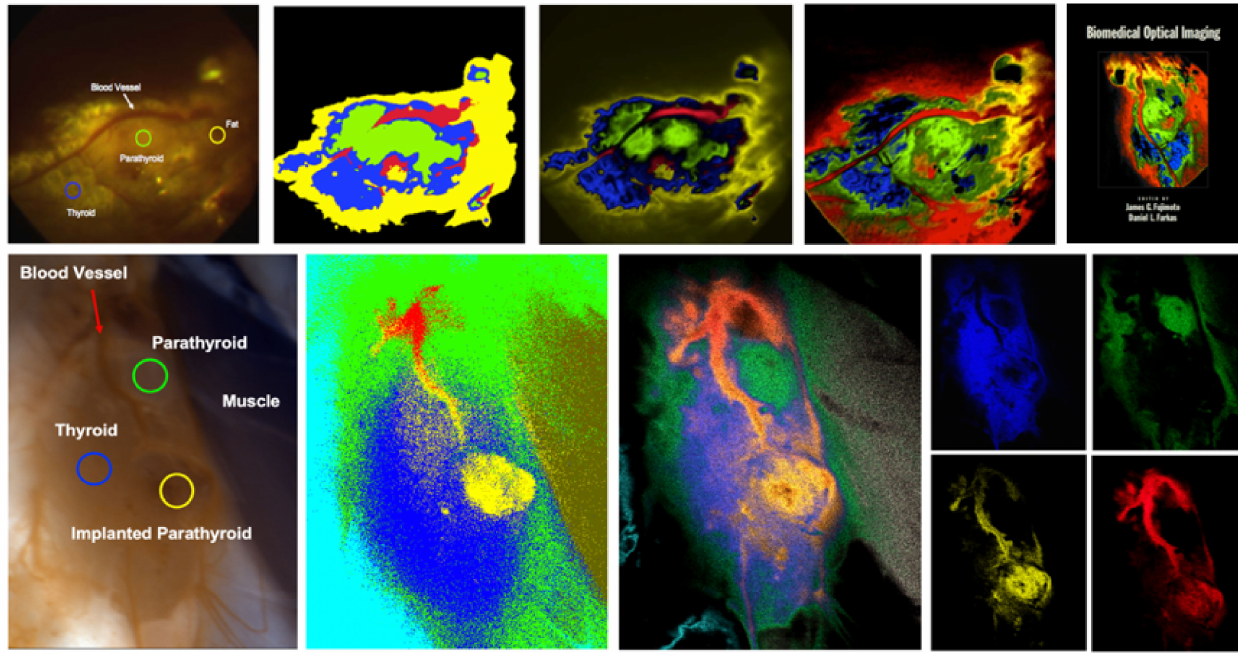
Figure 15. Intelligent spectral signature analysis and display options for in vivo tissue